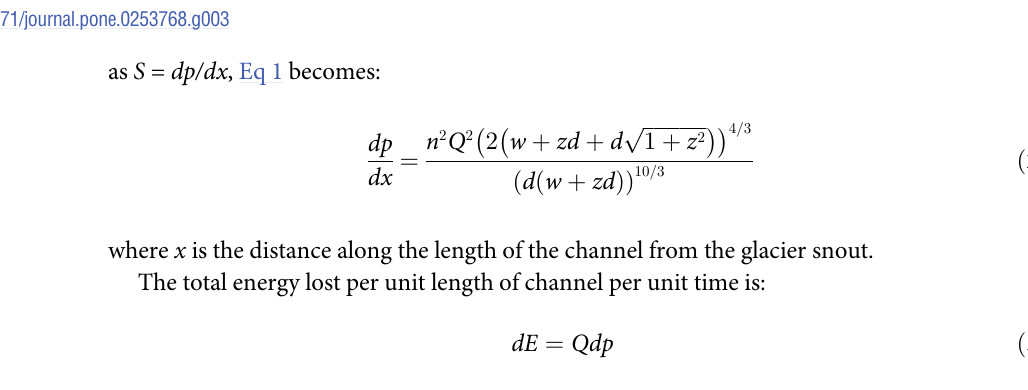
Fig 3. Illustration of a subglacial bedrock channel. Bedrock is present at three sides (brown; side closest to viewer not shown) and the glacier’s bottom provides an ice roof to the channel (white). Parameters shown are water depth, d, and channel width, w. The channel is completely filled with water (blue) that transports saltating (curved arrows) and suspended sediment (straight